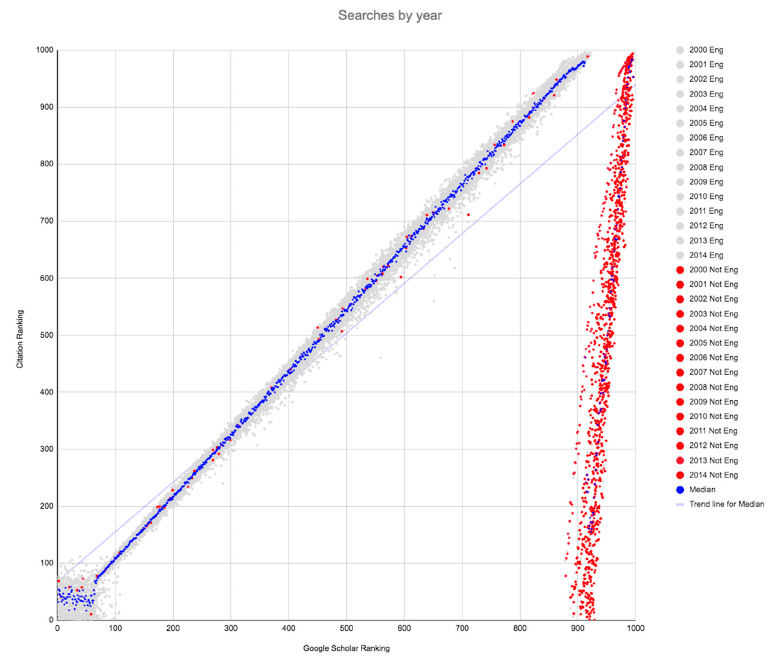
Figure 1. Scatter plot of searches by year. Future Internet 2021 , 13 , x FOR PEER REVIEW